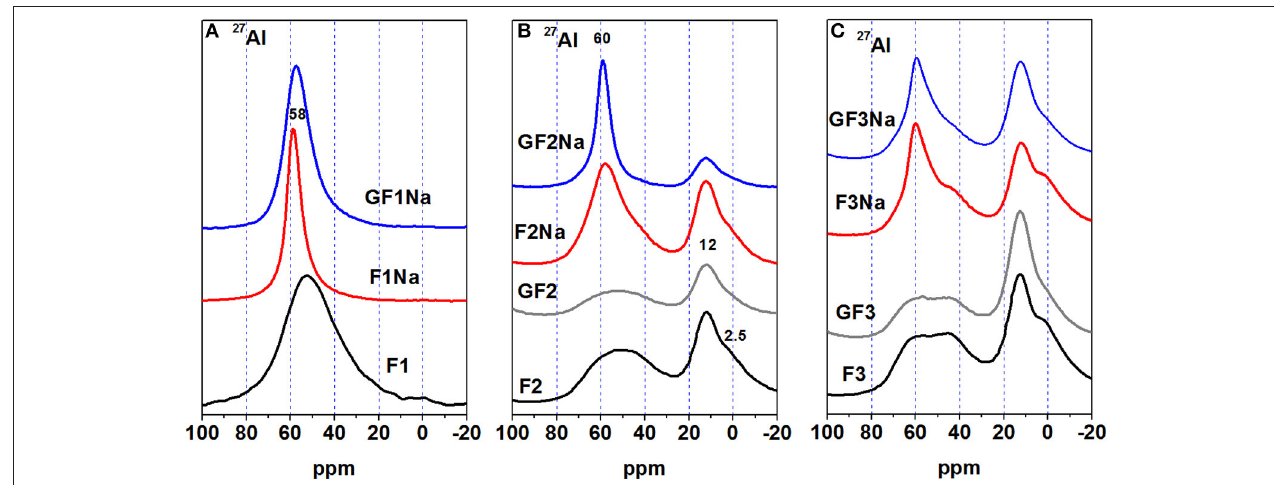
FIGURE 3 | 27 Al MAS-NMR spectra for ash (A) F1 (B) F2, and (C) F3.